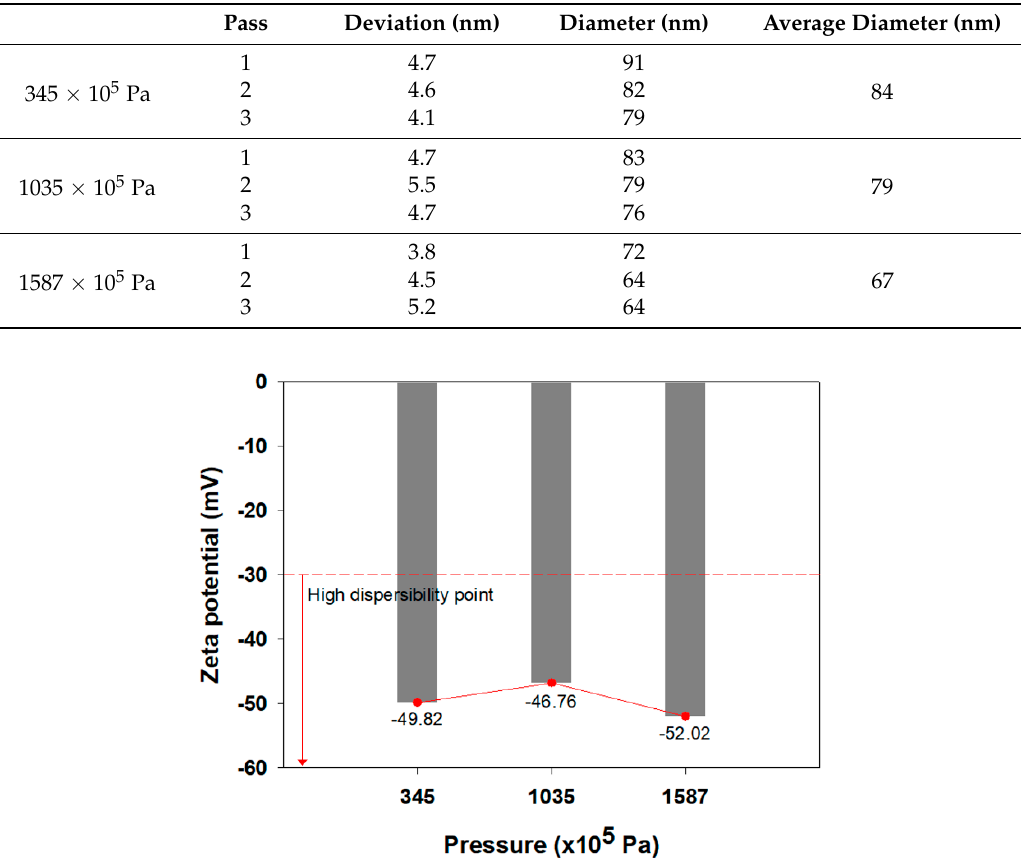
Table 6. Results of particle size analysis of samples subjected to high-pressure dispersion at different pressures and for different numbers of dispersion passes.